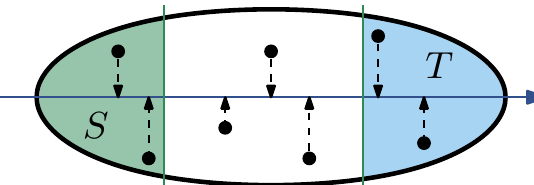
Figure 1. Inertial Flow projection and initialization. Nodes are projected onto their closest point on the blue direction. S and T are highlighted.